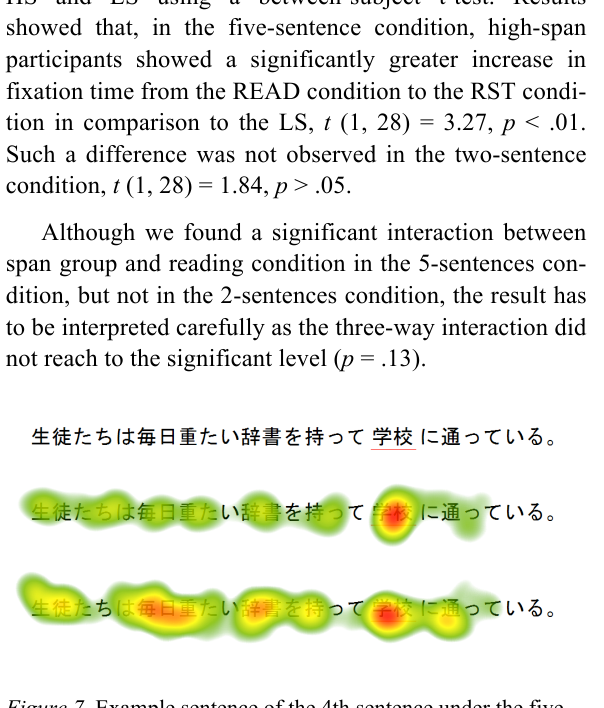
Figure 7 . Example sentence of the 4th sentence under the five- sentence condition. Top panel: original Japanese sentence (Eng- lish translation: The students go to school with heavy dictionary every day, underlined word is dictionary ). Middle panel: The heatmap of 7 high-span participants. Bottom panel: The heat- map of 8 low-span